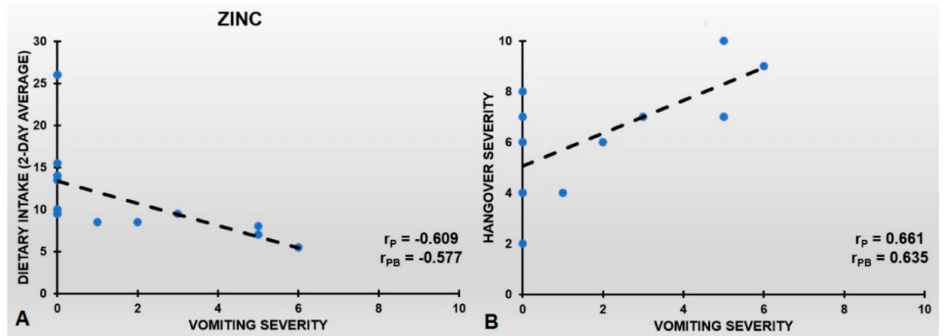
Figure 5. Severity of vomiting, dietary zinc intake, and overall hangover severity. ( A ) shows the partial correlation (r P ), controlled for eBAC, between dietary zinc intake (two-day average) and vomiting severity during alcohol hangover. ( B ) shows the r P , controlled for eBAC, between overall hangover severity and vomiting severity. After bootstrapping, both the corresponding r PB ’s are significant at the p < 0.002